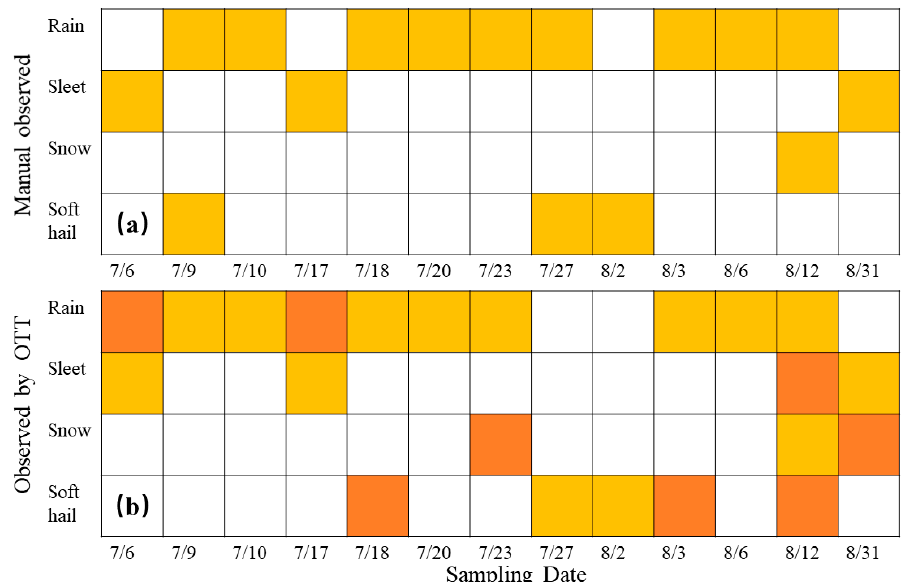
Figure 6. Types of precipitation identified ( a ) manually and ( b ) by the OTT Parsivel 2 instrument from July to August 2015. The yellow boxes indicate precipitation events recorded by both methods and the dark yellow boxes indicate precipitation events identified by the instrument, but not manually.